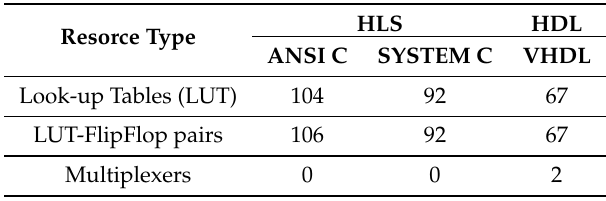
Table 1. Resource utilization for main